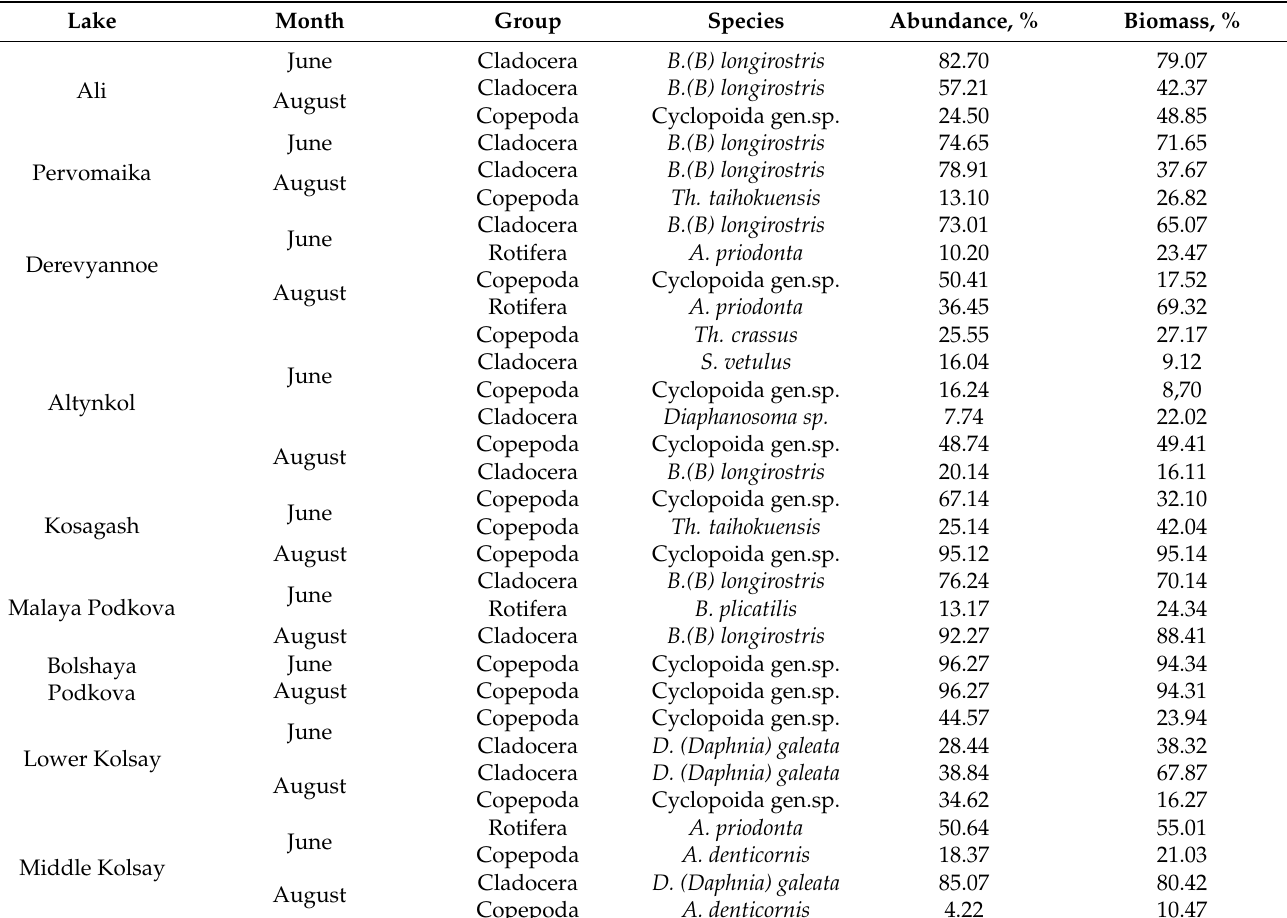
Table 9. Composition of dominant species in zooplankton of small lakes in South-East Kazakhstan, summer 2019.